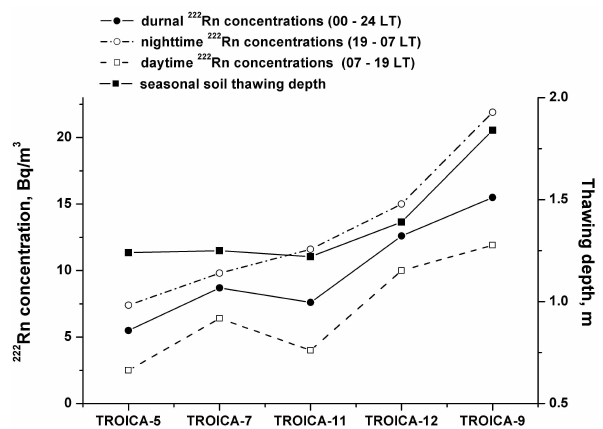
Fig. 4. Mean 222 Rn concentrations obtained from the TROICA data and the soil thawing depth calculated for the period of the expe- ditions in the region 52–55 ◦ N, 105–130 ◦ E using ECHAM5/MPI- OM model (SRES A1B